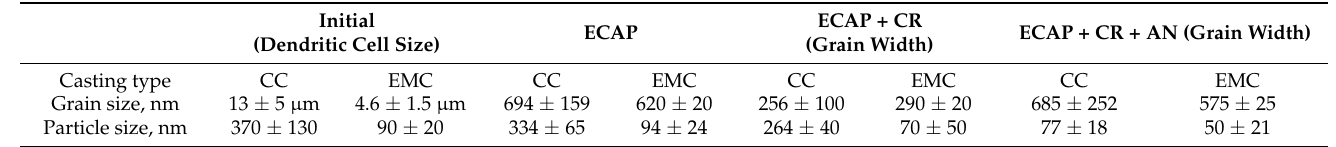
Table 3. Average grain and particle size in Al–1.7Fe